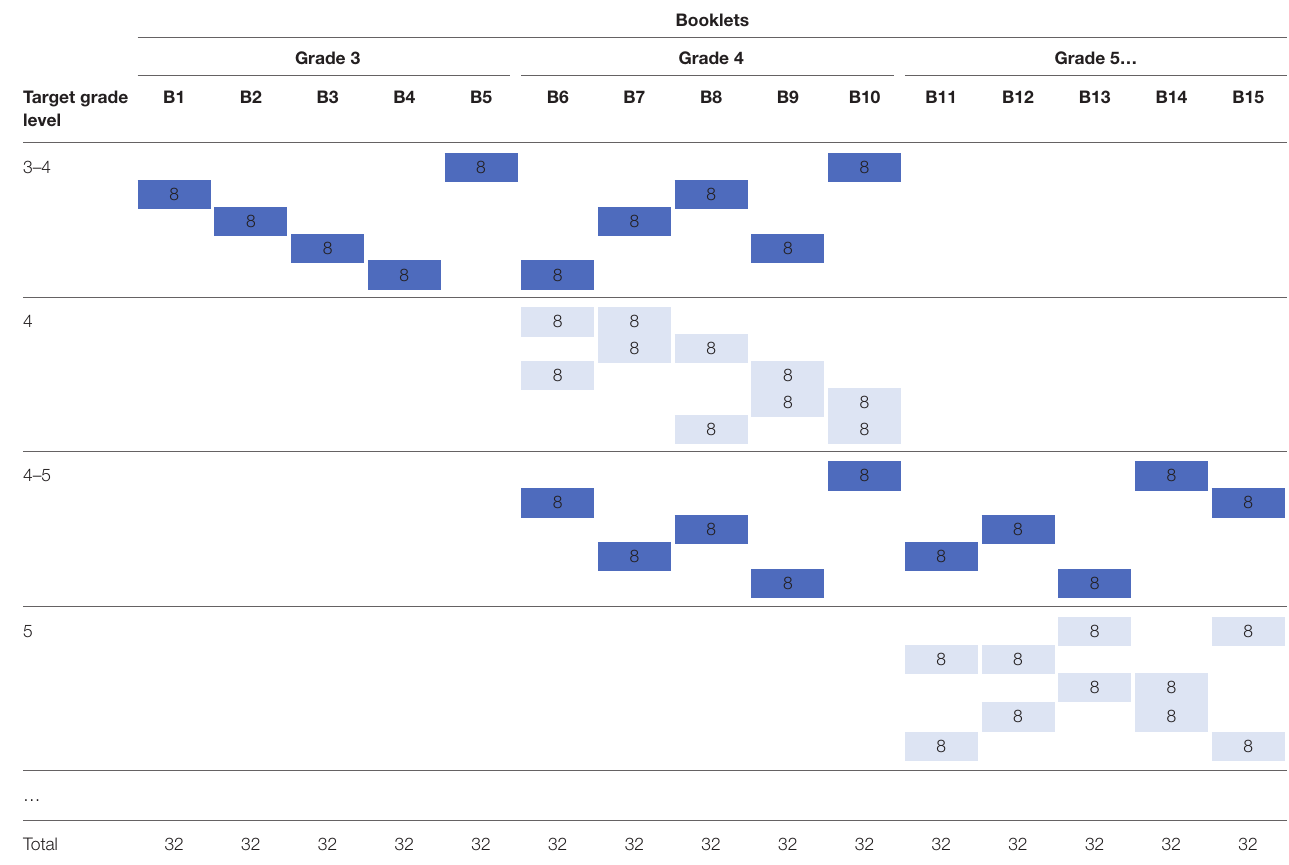
TABLE 3 | Extract of micro-level common item design.